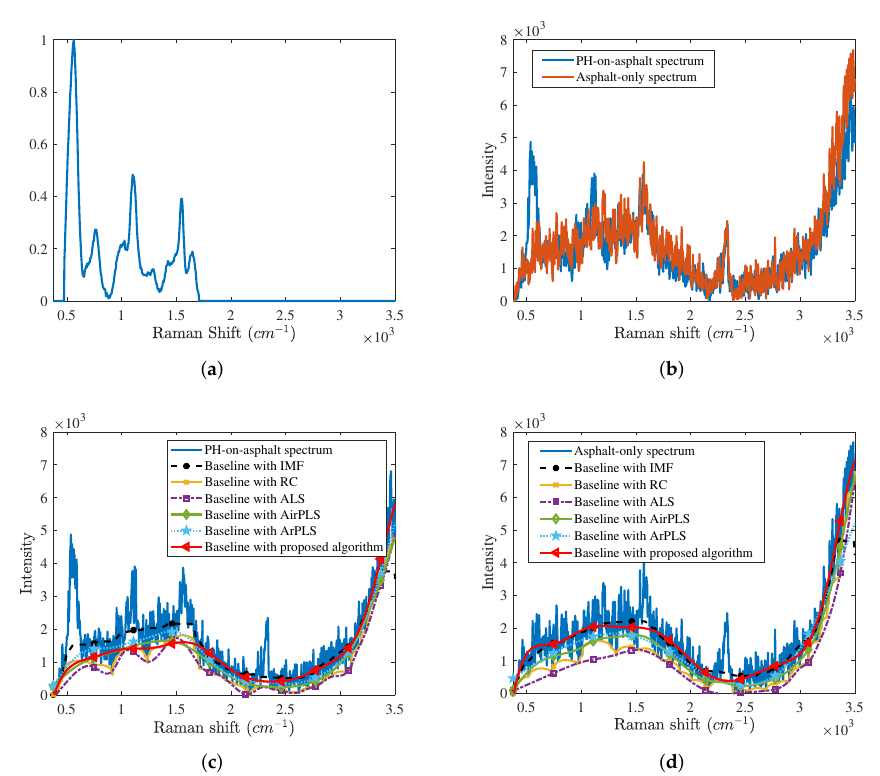
Figure 6. ( a ) Reference spectrum of the phosphorus trichloride (PH) and ( b ) PH-on-asphalt and asphalt-only spectra. Baselines estimated by several baseline correction algorithms from ( c ) the PH-on-asphalt spectrum and ( d ) the asphalt-only spectrum.